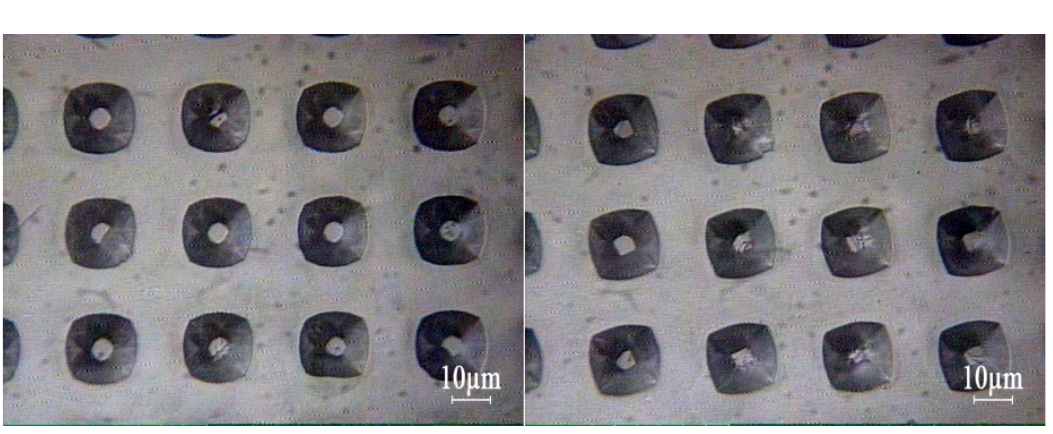
Figure 10. Microscopic inspection of a 22 wt % KOH, saturated with IPA, wet etch process, (Sample 4 in Table 1) after 50 min. Initial profile: 10 μm squares ( left ) aligned and ( right ) misaligned 22.5° with the wafer flat.